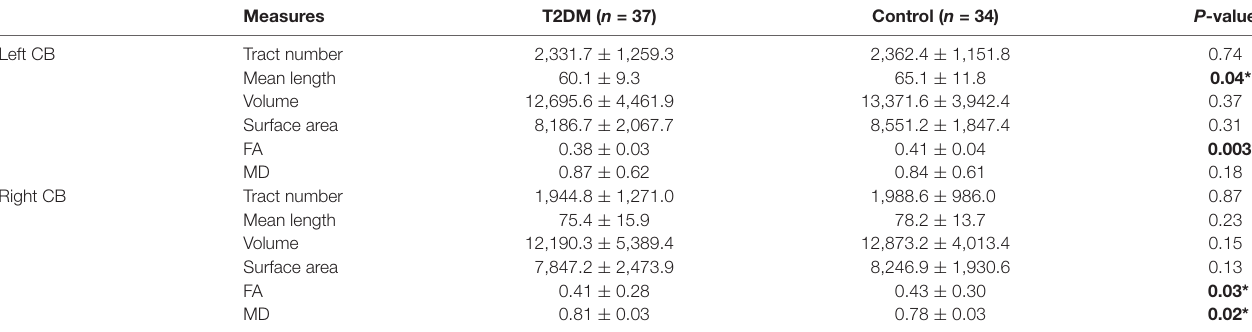
TABLE 3 | Diffusion measures of bilateral cingulum bundle in both